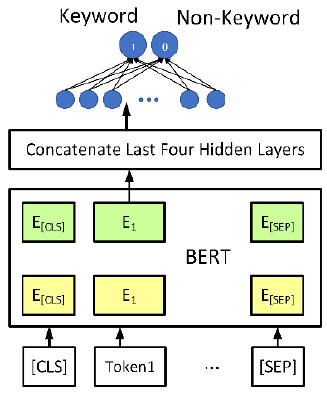
Figure 5. Keyword detection model. Table 2. Examples of keyword detection.